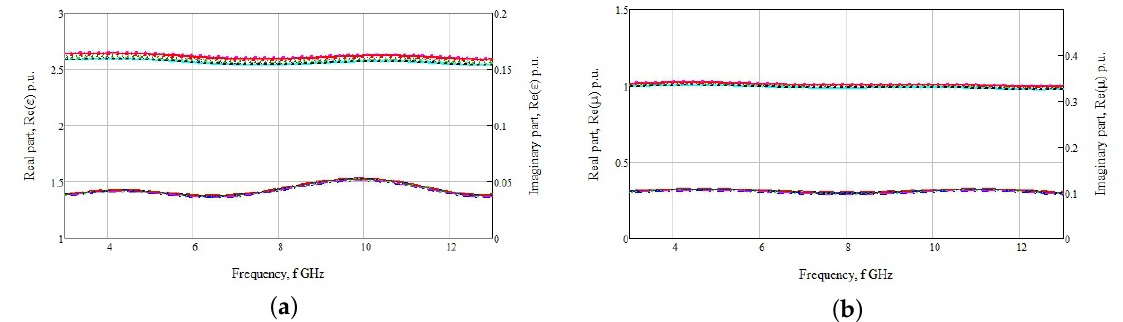
Figure 10. Measured values of relative dielectric ( a ) and magnetic ( b ) permeability for plexiglas.